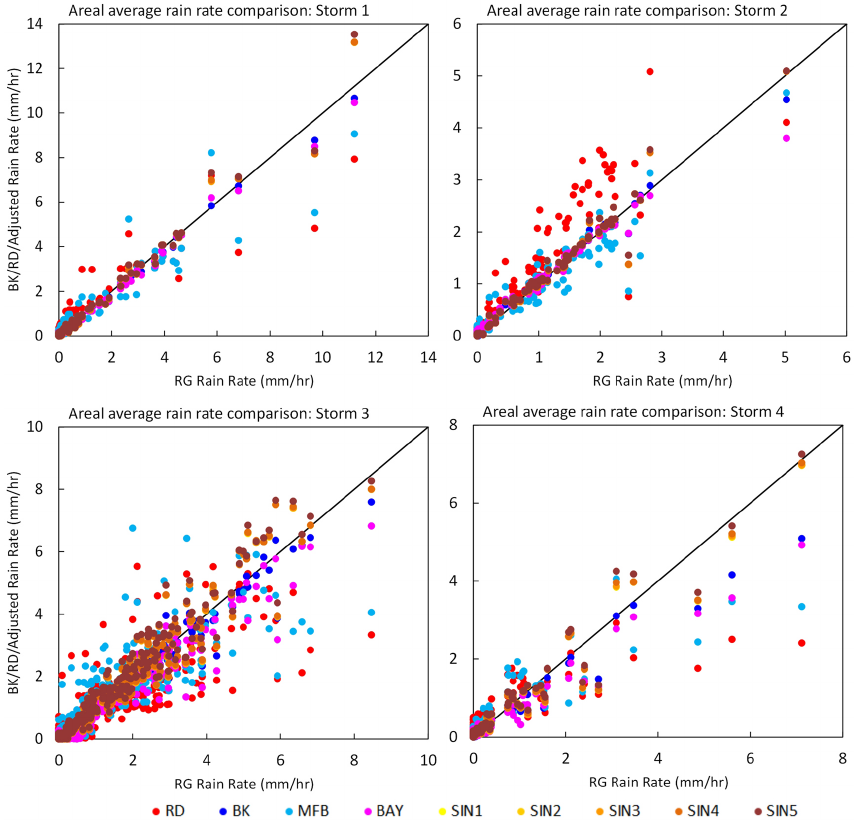
Figure 5. Scatterplots of instantaneous areal average RG vs. RD/BK/MFB/BAY/SIN rainfall rates over the Portobello catchment for the four selected events, where SIN1–SIN5 represent the SIN estimates with different “truncated” singularity ranges (from widest to narrowest).